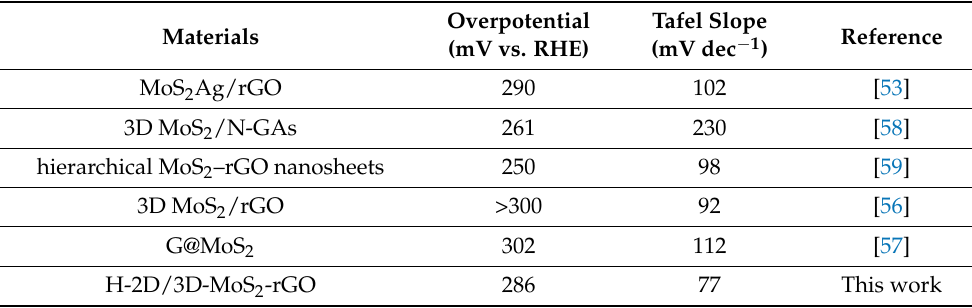
Table 1. Comparison of HER catalytic activities for the H-2D/3D-MoS 2 -rGO and other reported MoS 2 -based